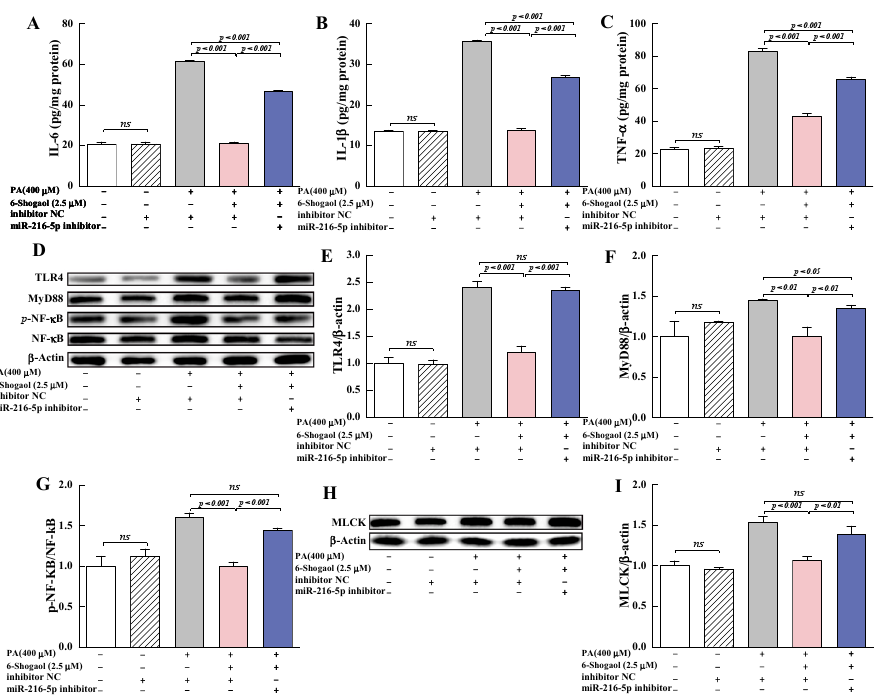
Figure 8. Effects of miR-216a-5p on pro-inflammatory cytokines and the TLR4/NF- κ B signaling pathway: ( A – C ) Effects of miR-216a-5p on the levels of IL-6, IL-1 β , and TNF- α ; ( D ) Representative immunoblotting of TLR4, MyD88, p-NF- κ B, and NF- κ B; ( E – G ) Effects of miR-216a-5p on the expres- sion of TLR4 and MyD88, and the phosphorylation of NF- κ B; ( H ) Representative immunoblotting of MLCK; ( I ) Effects of miR-216a-5p on the expression of MLCK. Data are given as means ± standard deviations (n = 3). ns indicates no significant difference at p < 0.05.